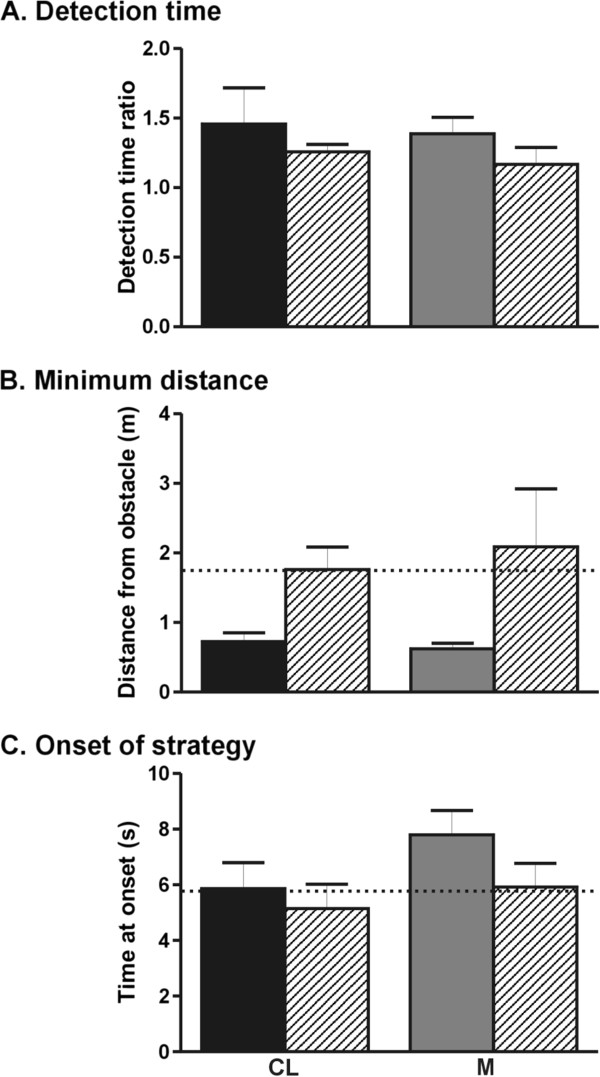
Mean (±1SD) values for A) obstacle detection times [perceptuo-motor task], B) minimum distances and C) onset time of avoidance strategy for the colliders (solid bars) and non-colliders (lined bars) [locomotor task] are represented for the contralesional (CL) and middle obstacle (M). Mean values across all participants for the ipsilesional obstacle approach are represented by the dotted line to provide a reference value.